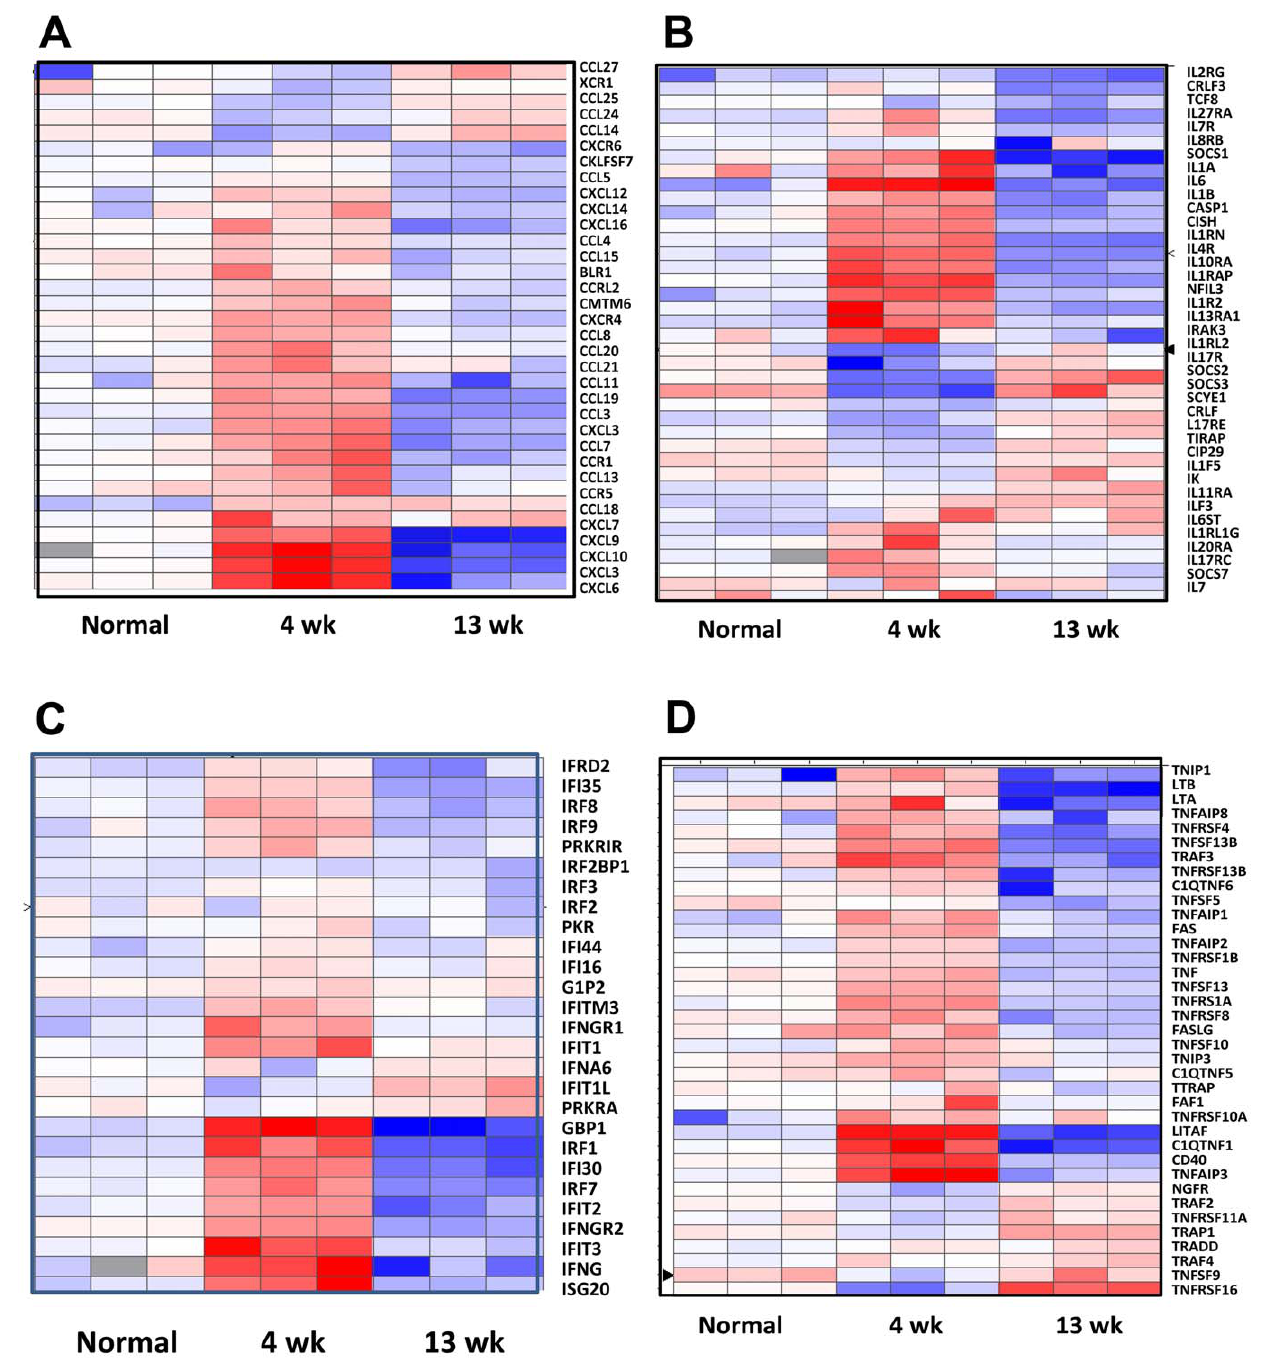
Figure 3. Clustering analysis of specific immune categories. Clustering analysis represents the differences in gene expression in early and late lesions between specific immune categories: chemokines and their receptors (A), cytokines and their receptors (B), IFN c network (C) and TNF network (D). The coloring scheme is white -no change in expression, blue – lower expression in lesion samples relative to normal lung, and red – higher expression in lesion samples relative to normal lung. Each column represents results obtained from one distinct animal.